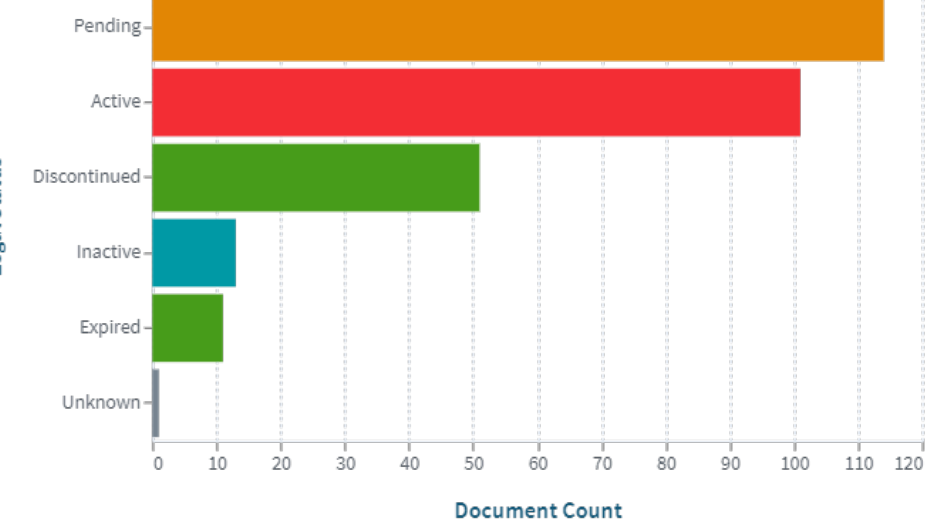
Figure 2. Patent documents by legal status (https://www.lens.org, accessed on 30 July 2022).